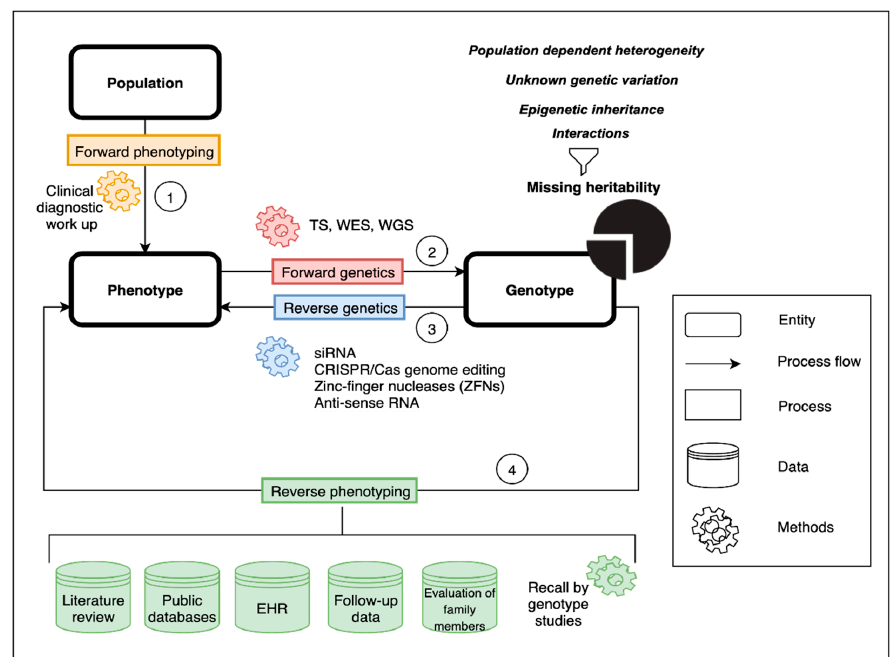
Figure 1. Graphical abstract. Schematic representation of the concepts of forward phenotyping (1) and